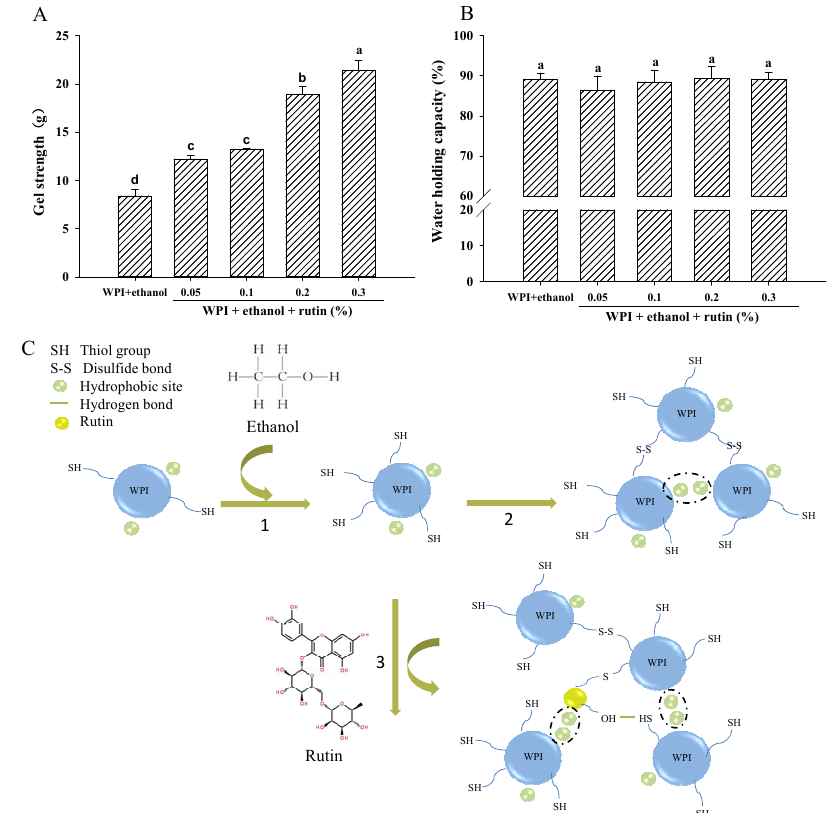
Figure 6. The effects of ethanol (15% v / v ) and different levels of rutin (0.05%, 0.1%, 0.2% and 0.3% w / v ) on the gel strength ( A ), water ‐ holding capacity ( B ) of WPI ‐ based gels and the proposed inter ‐ actions of WPIs induced by ethanol and rutin ( C ). Means with different letters (a–d) differ signifi ‐ cantly ( p < 0.05). 1. Unfolding of the WPI structure and exposure of the thiol groups and hydropho ‐ bic sites of WPI; 2. Cross ‐ linking of WPI via hydrophobic interactions and disulfide bonds induced by ethanol; 3. Rutin might act as a cross ‐ linker via hydrophobic interactions and formation of thiol– quinone adducts and hydrogen bonds with WPI.